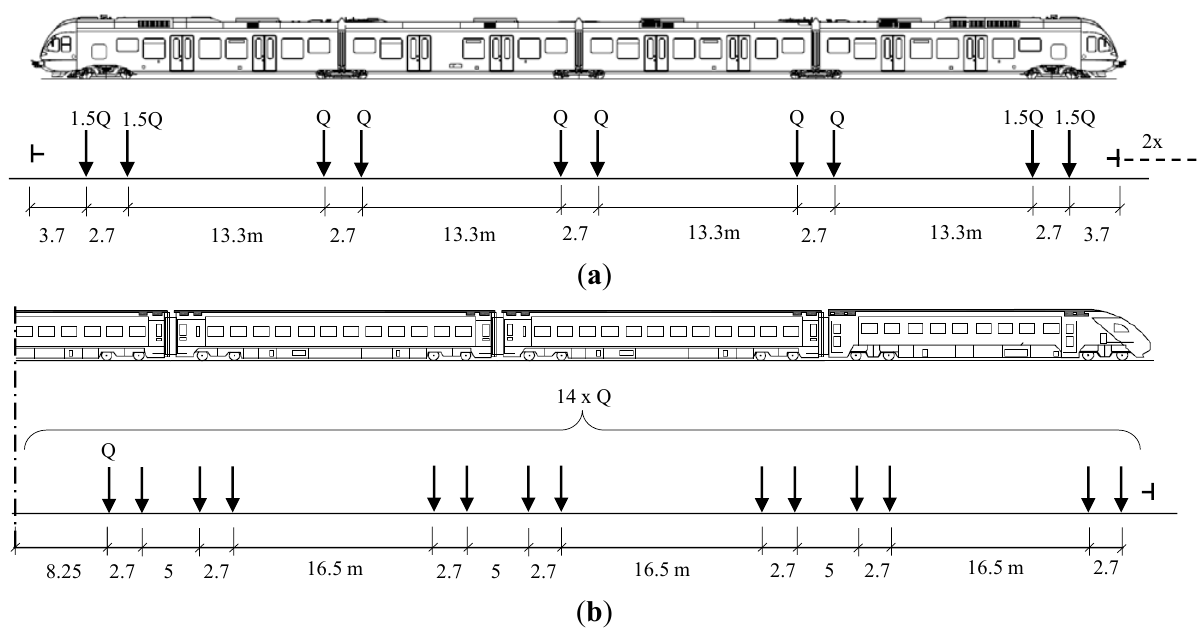
Figure 7. Load models of ( a ) S3 train; and ( b ) Intercity (ICN) train.